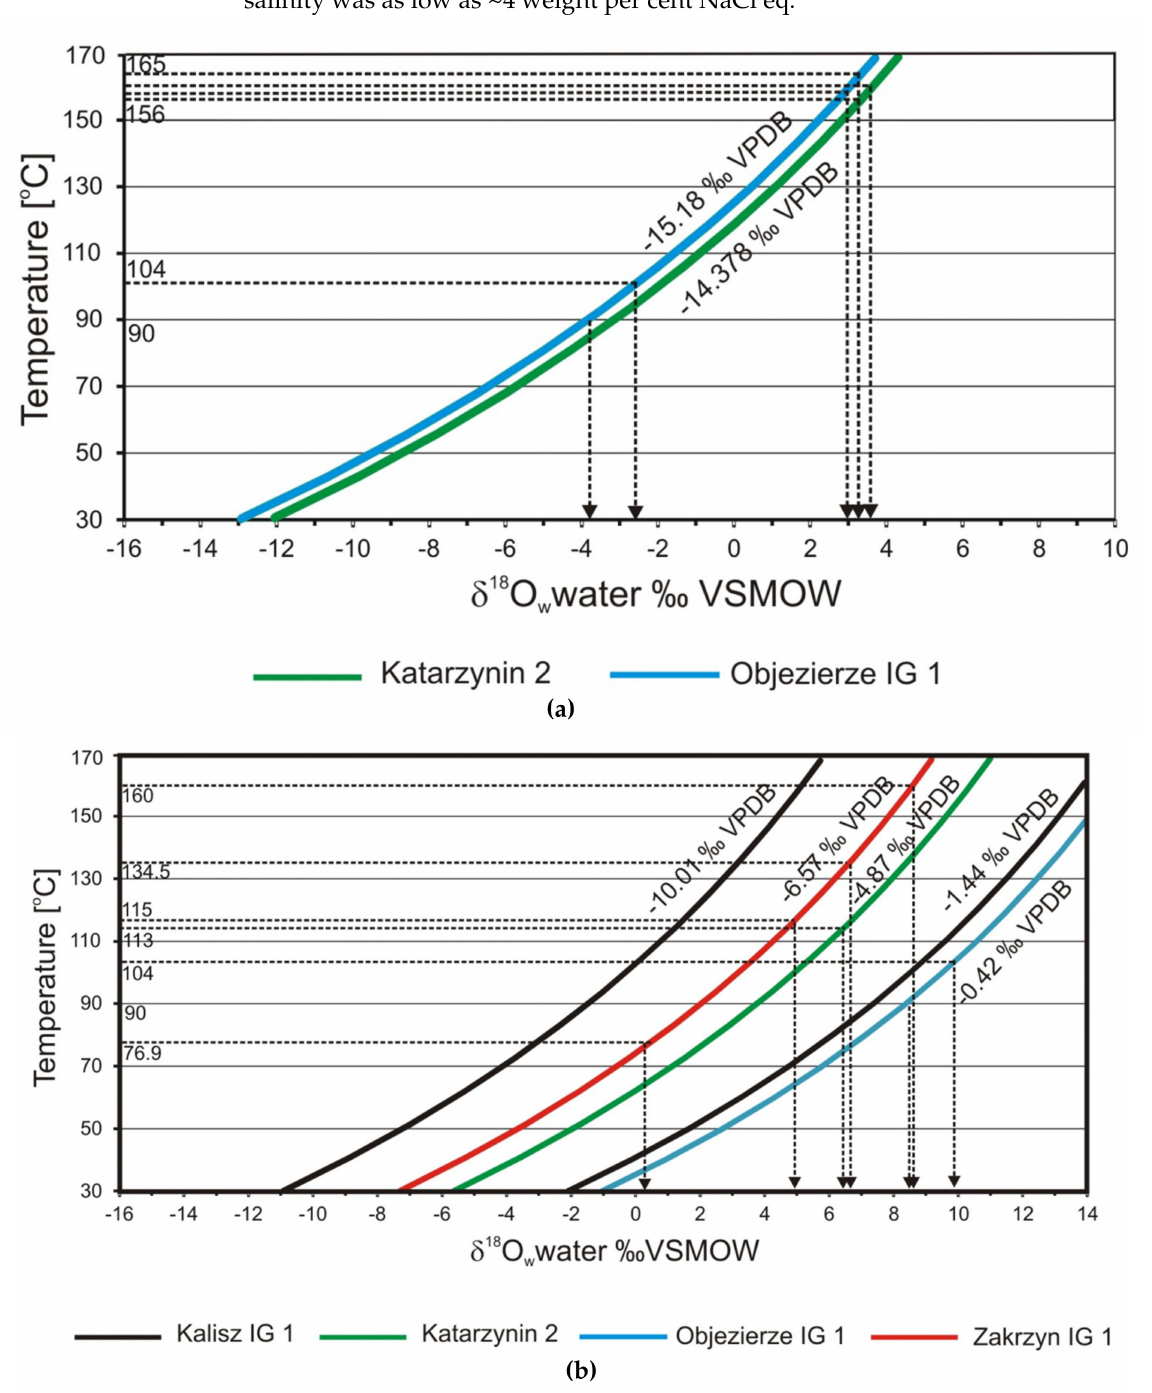
Figure 12. ( a ) Plot of δ 18 O pore water versus temperature for calcite (after [53]); ( b ) Plot of δ 18 O pore water versus temperature for Fe-dolomite/ankerite (after